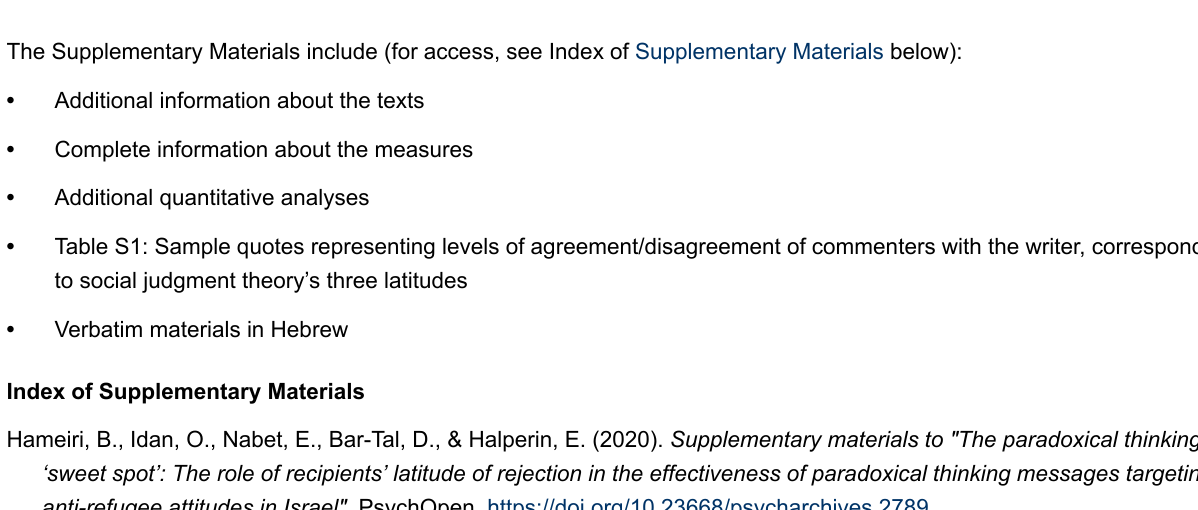
Table S1: Sample quotes representing levels of agreement/disagreement of commenters with the writer, corresponding to social judgment theory’s three